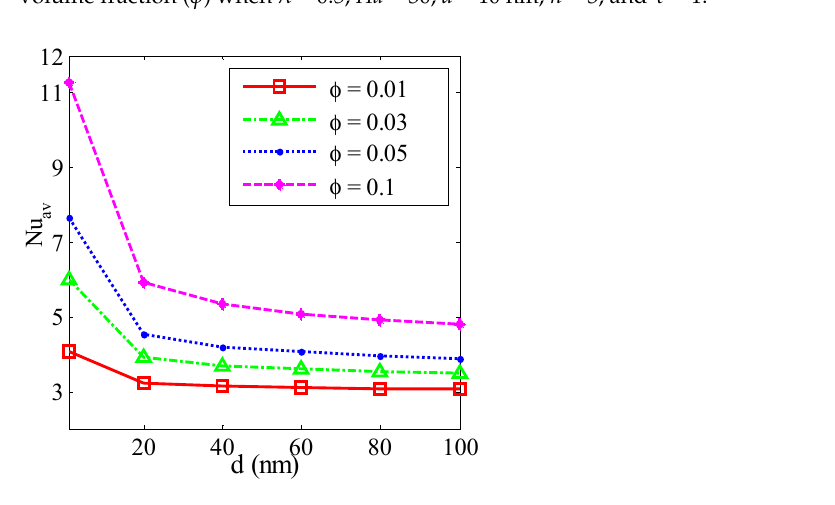
Figure 13. Average Nusselt number ( Nu av ) for different nanoparticles diameter ( d ) and nanoparticles volume fraction ( ϕ ) when Ra = 10 6 , Ha = 30, λ = 0.5, d = 10 nm, n = 3, and τ = 1.